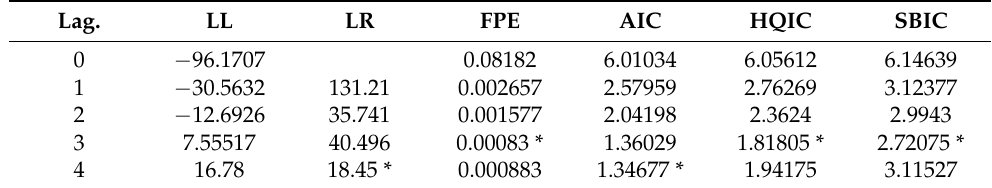
Table 5. VAR lag length selection criteria.